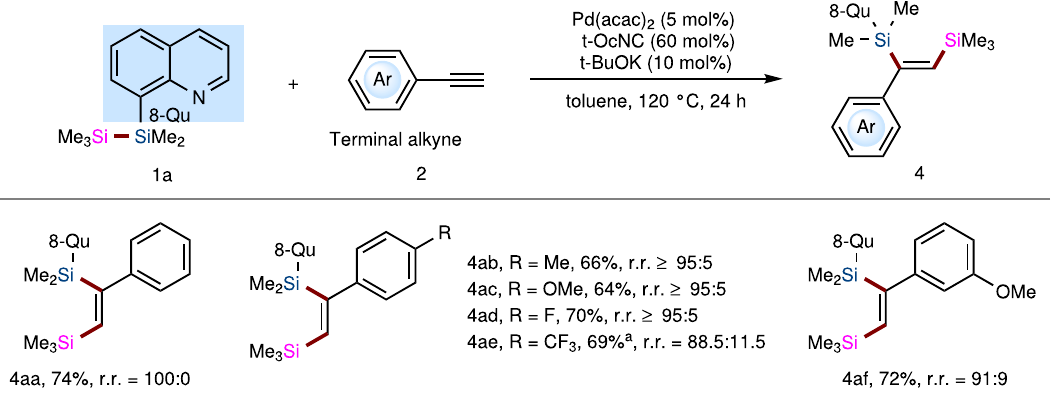
Fig. 3 The bis-silylation reaction of TMDQ reagent 1 with terminal alkyne 2. Standard reaction conditions: disilane 1a (52 mg, 0.2 mmol), terminal alkyne 2 (41 mg, 44 μ L, 0.4 mmol), Pd(acac) 2 (3 mg, 0.01 mmol), t -OcNC (17 mg, 0.12 mmol), and t -BuOK (2.3 mg, 0.02 mmol) in toluene (2 mL) at 120 °C under N 2 atmosphere for 24 h. See Supplementary Information (SI) for details.